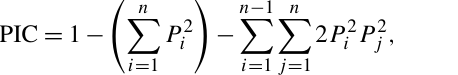
Table 1. Allele and genotype frequencies of the AMH exon 2.